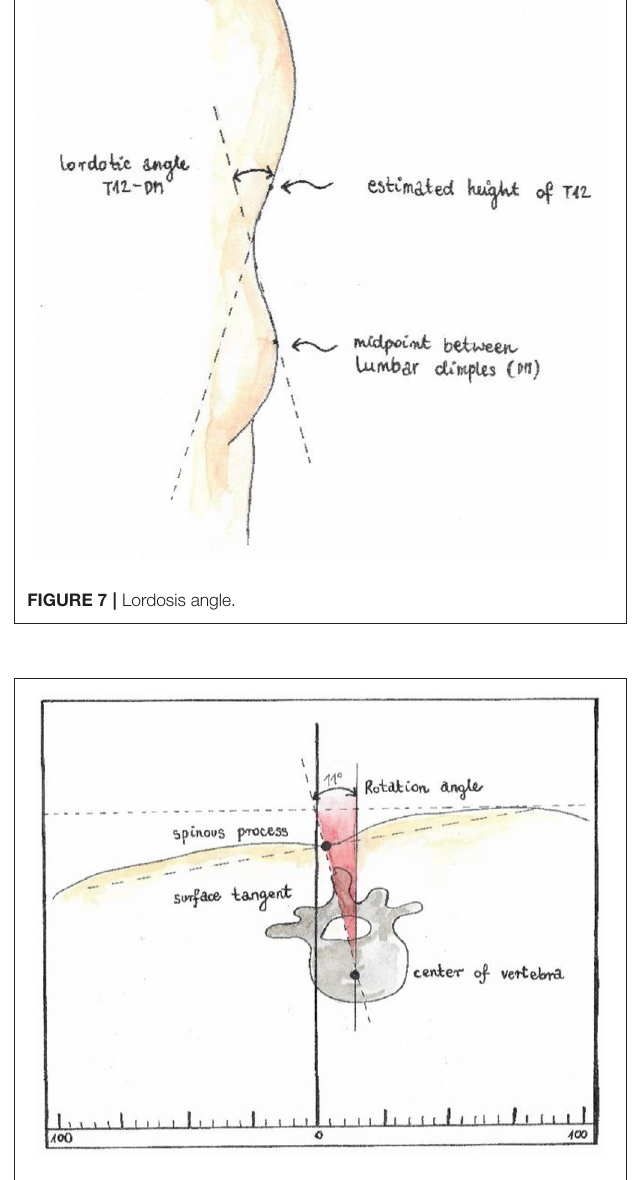
FIGURE 8 | Surface